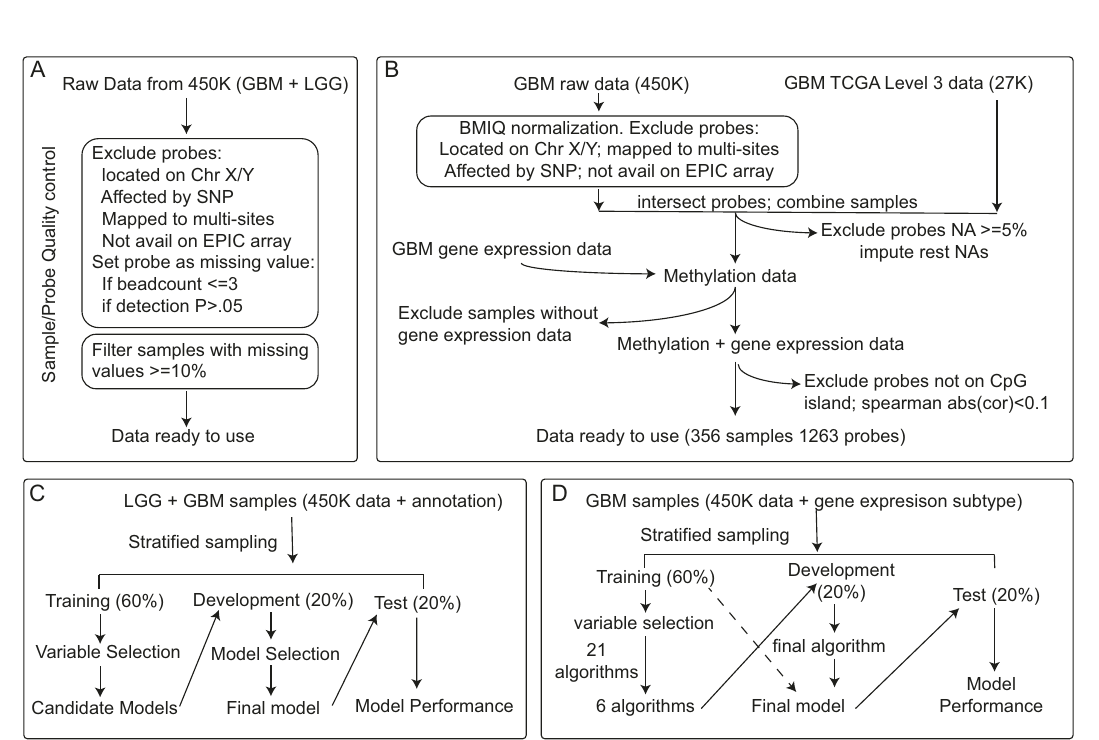
Fig. 4 Classi fi cation comparison between UniD and Unsupervised CNS Classi fi cation. A All samples with HM450K data available were classi fi ed into nine subgroups according to their methyl-based genetic alterations. The number of samples for each subset is also provided. The Unsupervised CNS Classi fi cation predicted categories are summarized for each subgroup in the rightmost column. B By comparing the predicted annotation between the UniD and Unsupervised CNS Classi fi cation, all discordant samples were picked out with detailed information. The left column shows the discordant samples and their subgroup belonging in ( A ). The right column shows the rationale for why they were discordant samples. C Boxplot shows the comparison of ABSOLUTE tumor purity between the samples classi fi ed into CONTR categories (classi fi ed-normal) and samples classi fi ed as tumor categories (classi fi ed- tumor) according to Unsupervised CNS Classi fi cation. Each point represents for one sample (classi fi ed-normal n = 39, classi fi ed-tumor n = 565). Boxplot center line represents median value, lower and upper hinges represent 25th and 75th percentiles, and lower and upper whiskers represent 1.5 interquartile ranges above and below box limits or maximum/minimum, whichever is closest to median. D SNP6-based CNV pro fi le of the 12 samples in Grp2 (six CONTR, HEMI samples; three A IDH samples; and three A IDH, HG samples) clearly showing chr1p19q codel. The upper and lower panels show the pro fi le of chr1 and chr19, respectively. E Whole genome CNV pro fi le derived SNP6 array for the samples classi fi ed as SFT, HMPC in Grp7. F Kaplan – Meier plot with overall survival time (months) for the fi ve enriched subgroups in ( A ) (Grp1, 2, 3, 7, and 8). The risk table is provided below. G Log-rank test was used to compare every two subgroups. P values are provided in the table.